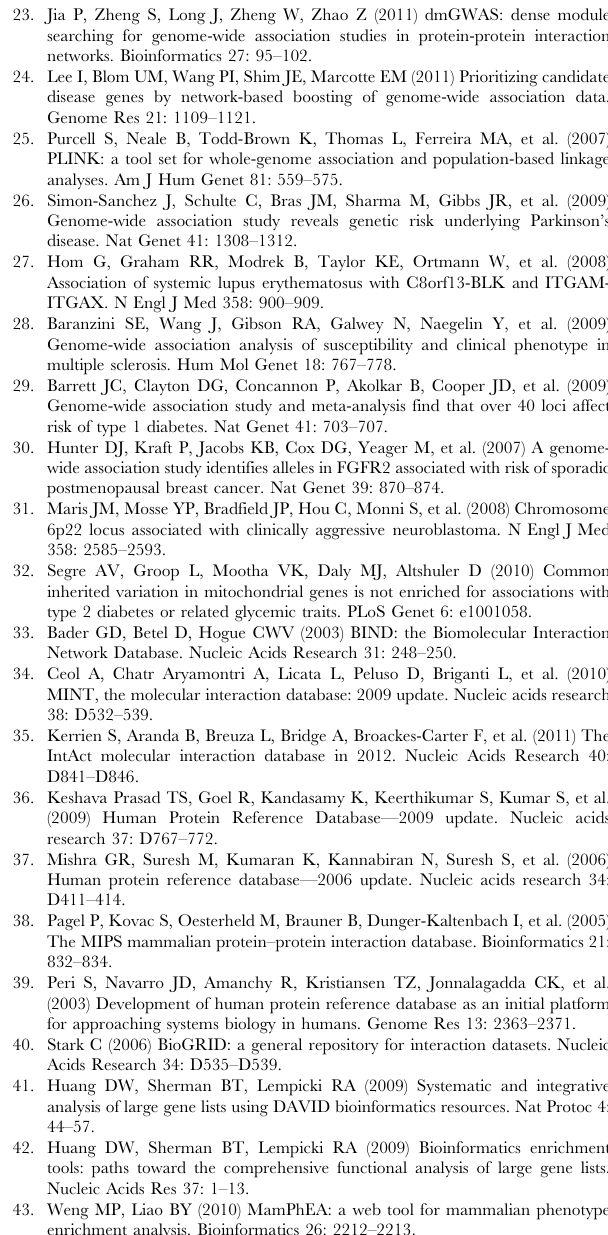
Table S2 AGP LCC network genes. List of the 416 genes included in the AGP LCC with information on gene-wise association P -value, specificity score for ASD and previous findings regarding implication in ASD and other neurological disorders.